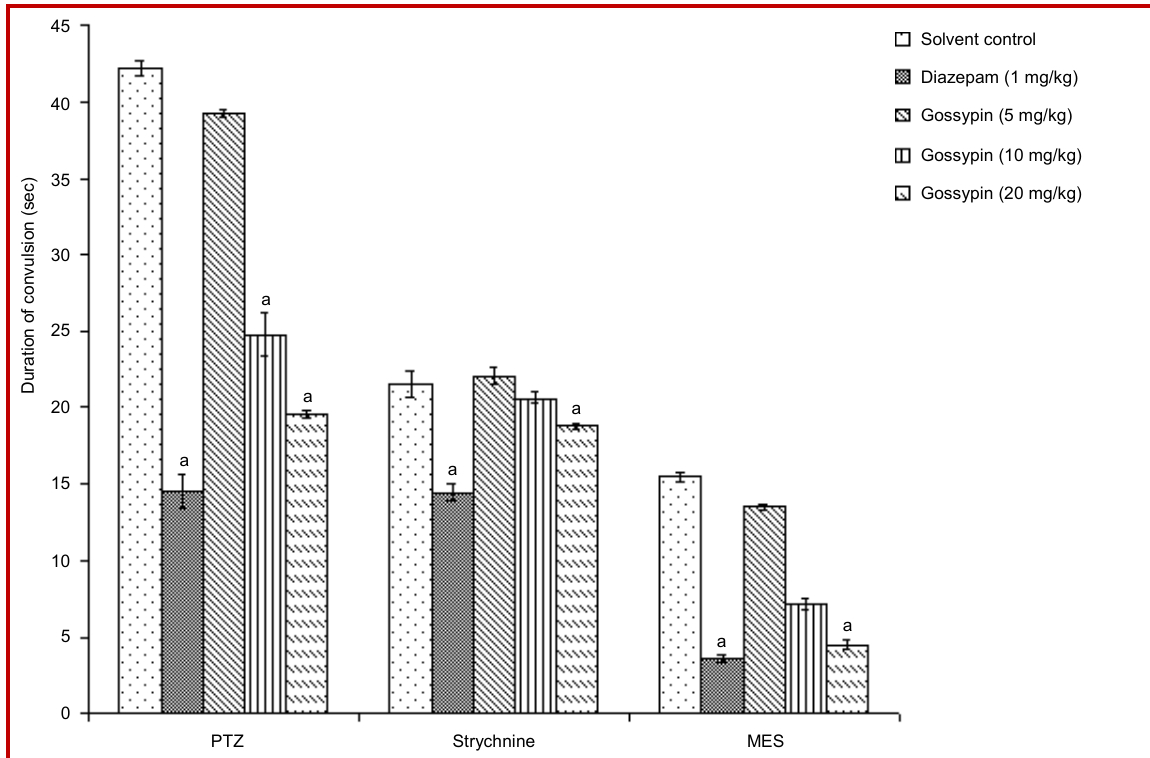
Figure 1: Anticonvulsant activity of gossypin on pentelenetetrazole- (PTZ), strychnine- and maximal electroshock (MES)-induced seizure in mice. Values were expressed as mean ± SEM (n = 6); a p<0.01 vs solvent